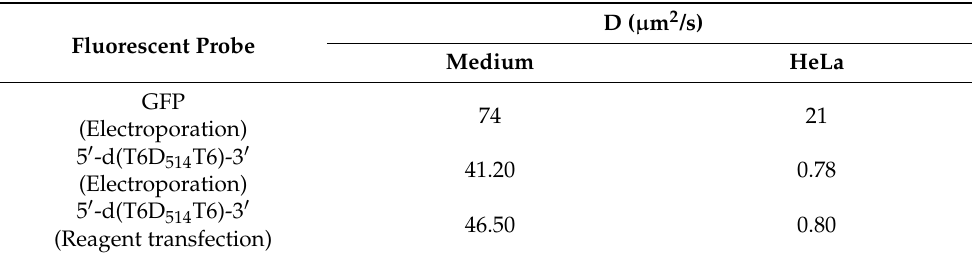
Table 1. Comparison of mean diffusion coefficients D of the D 514 probe and GFP in medium and in HeLa cells.